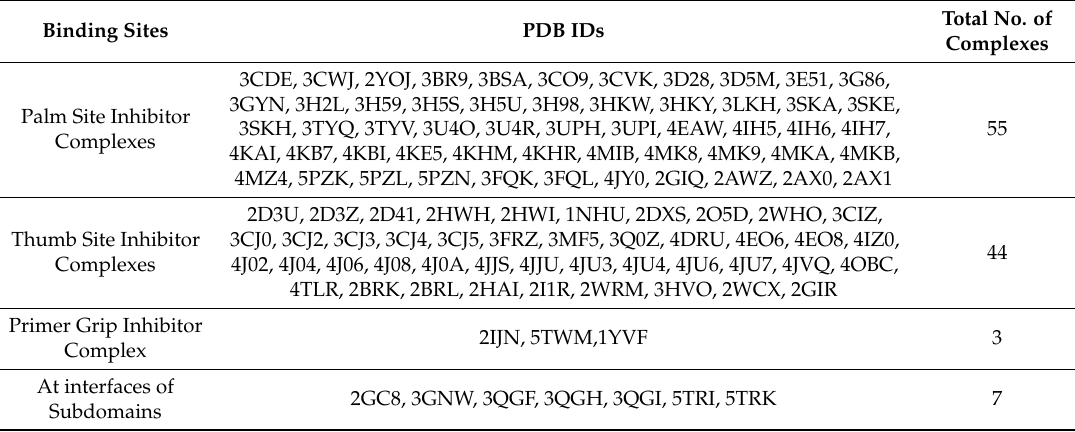
Table 3. List of the structures of non-nucleoside inhibitor complexes of the RdRp of